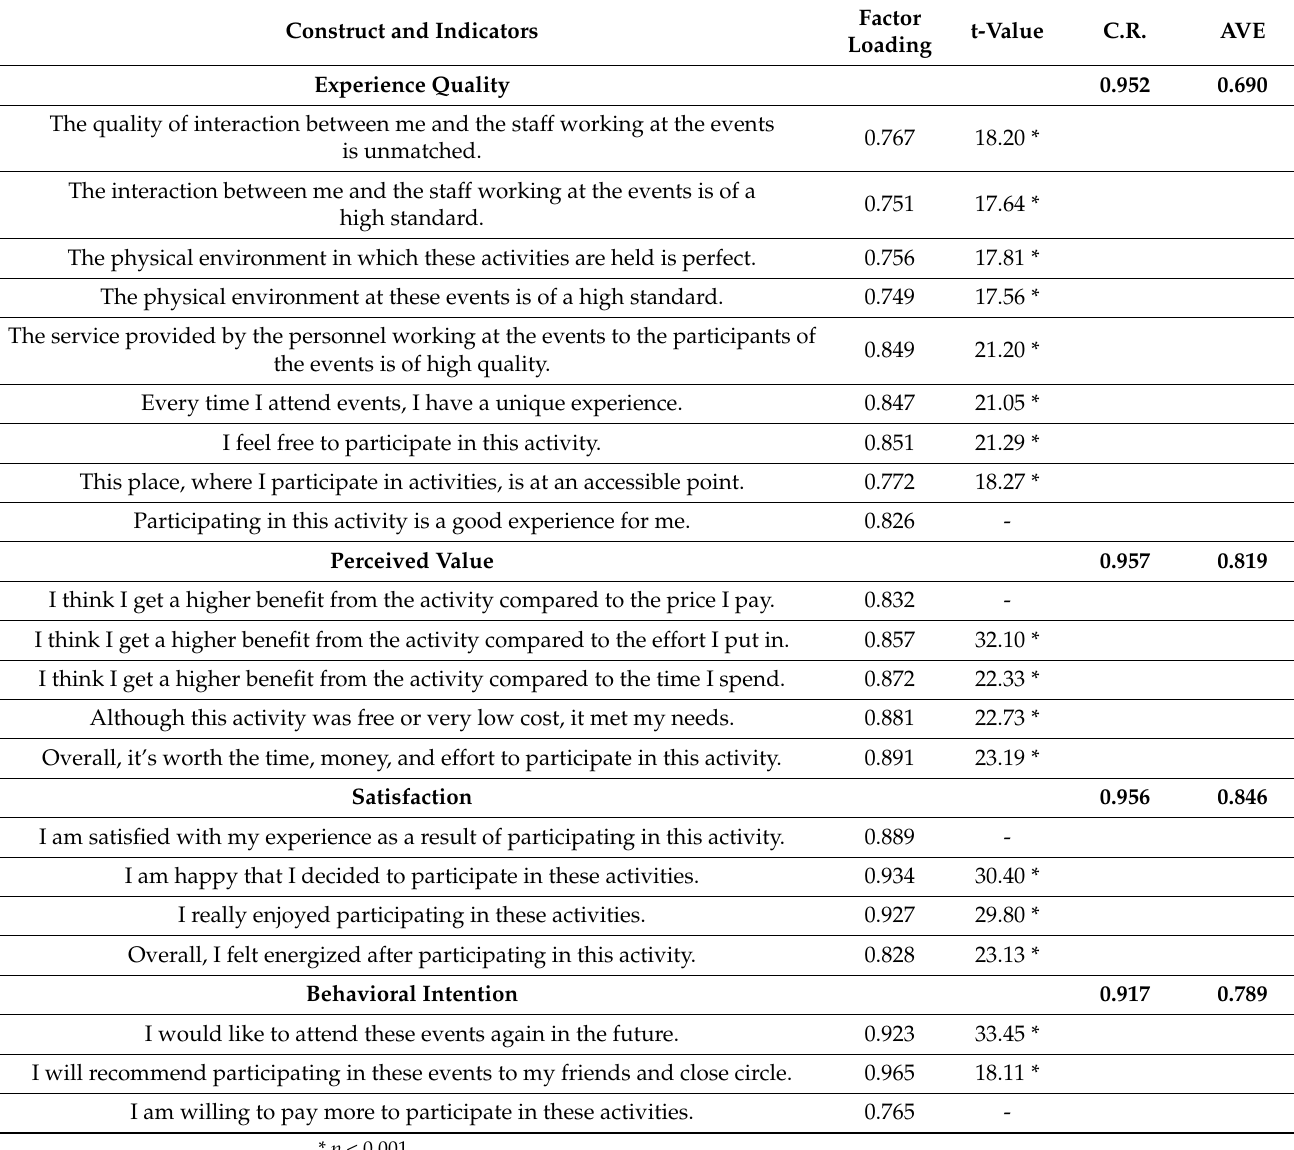
Table 2. Overall CFA for the measurement model ( n =